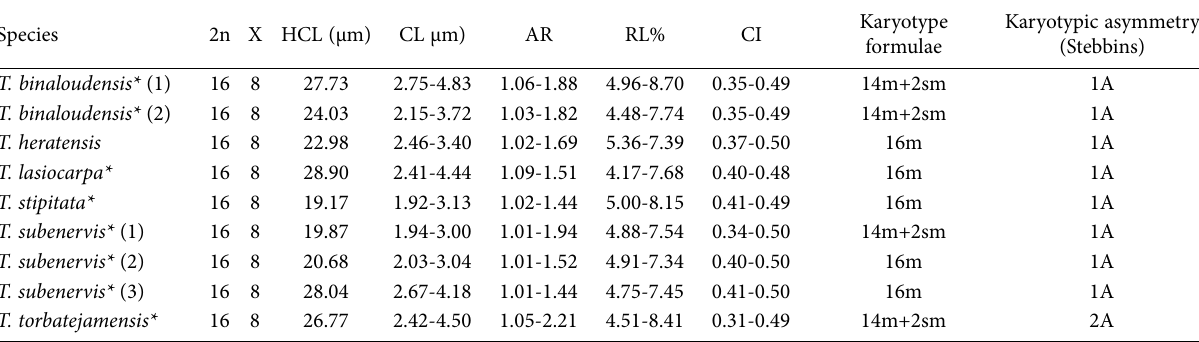
Karyotype Karyotypic asymmetry formulae (Stebbins)